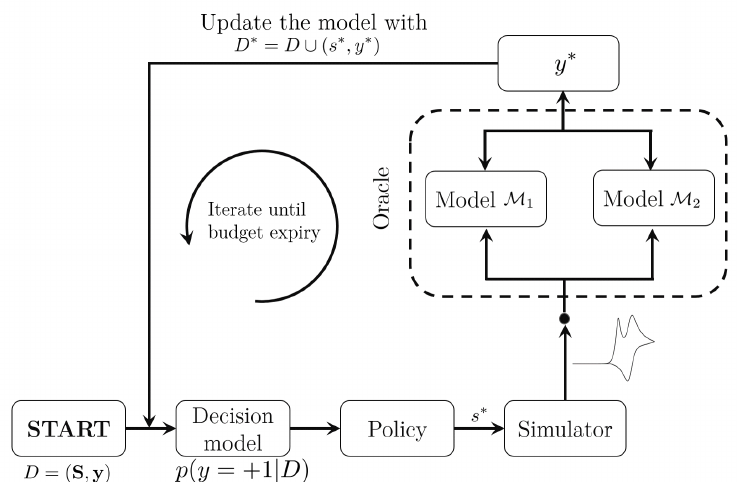
Figure 1. Active learning framework as a flowchart. Active learning iterations start with a few labeled data points in the search space S . We stop collecting data when we have selected a pre-defined number (called budget) of locations for updating our decision (or belief)